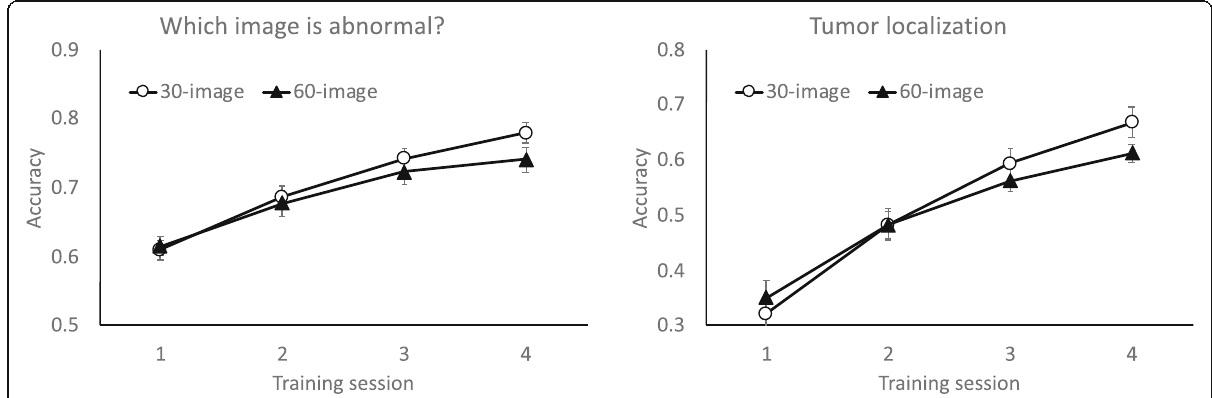
Fig. 3 Accuracy across four sessions of training. Left: image classification (which image is abnormal?). Right: tumor localization. Data from the 30- image training schedule came from 36 participants (12 from experiment 1A and 24 from experiment 3). Data from the 60-image training schedule came from 24 participants (12 each in experiments 1B and 2). Error bars show +/ − 1 S.E. of the